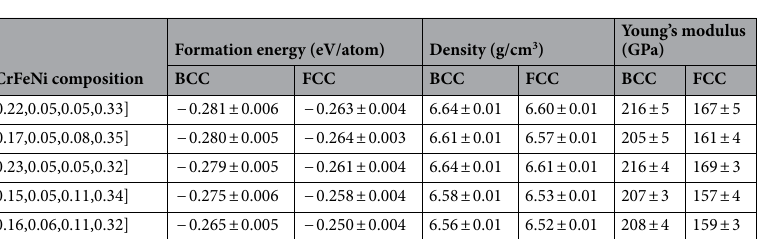
Table 1. The top-five most energetically stable compositions for the AlCoCrFeNi HEA with a BCC lattice. The calculated formation energy per atom, mass density and Young’s modulus are compared with those with an FCC lattice at the same HEA composition. Error bars indicate the standard deviation of averaging over a set of SSOS solutions.